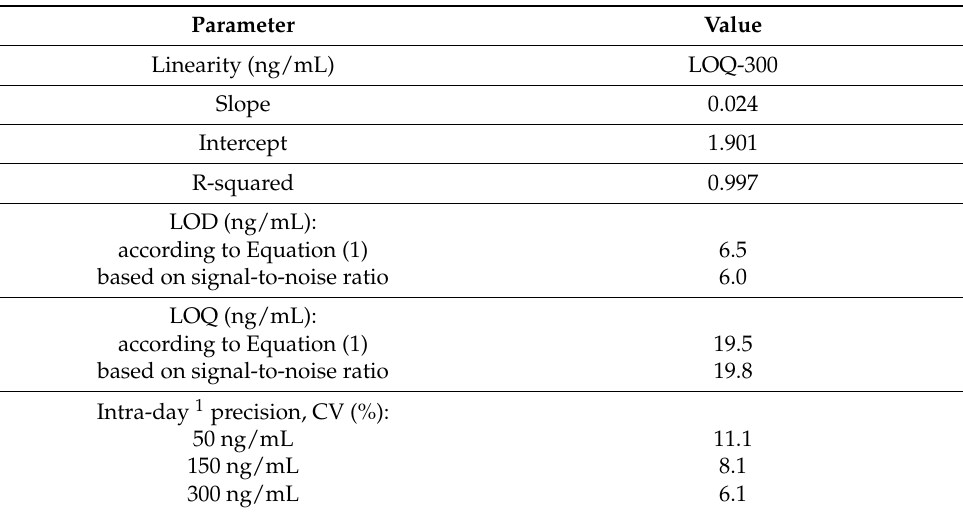
Table 1. Validation parameters for ketamine in blood samples.